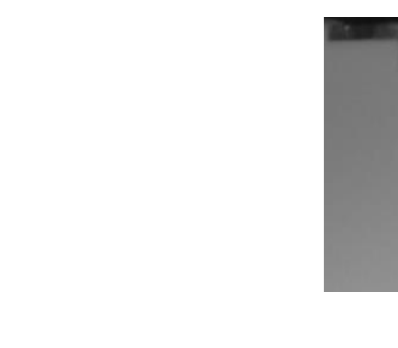
Figure 16. Size calibration of CCD. ( a ) Draw lines on the hohlraum to mark its front size; ( b ) Draw a line on the hohlraum to mark its left side size.